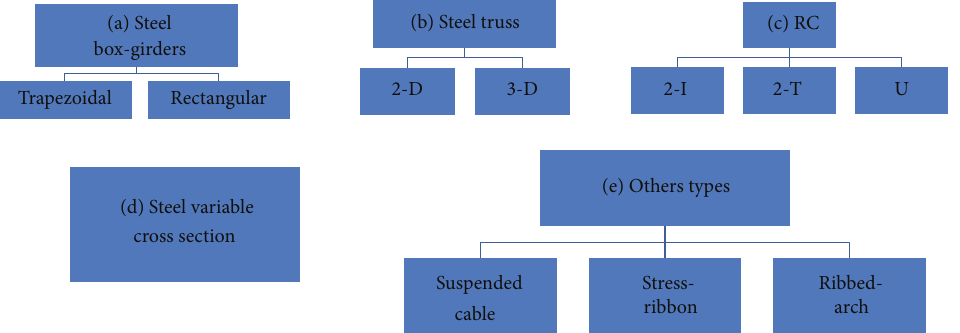
Figure 2: Main structural deck types for footbridges in